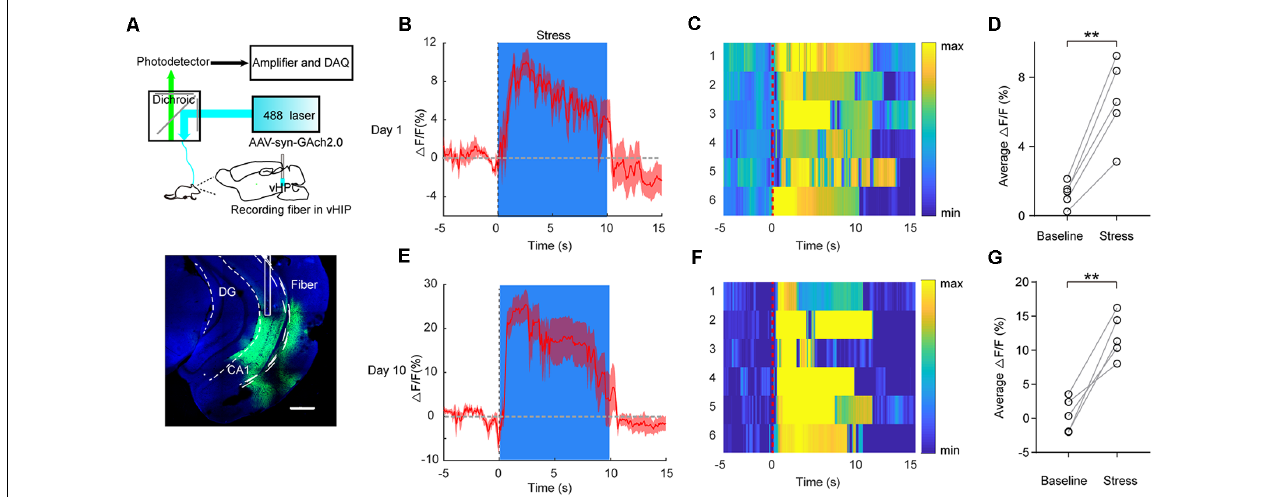
FIGURE 2 | Transient restraint stress increases ACh muscarinic receptor (mAChR) signal in behaving mice. (A) Left, schematic of the fiber photometry setup. Right, a representative image validates GAch2.0 expression (green) and optical fiber tract above the vHPC. Scale bar, 500 µ M. (B,C) PETH plot (B) and heat map (C) of fluorescence transients from a representative mouse aligned to the start of the restraint stress. (D) Quantification of change in fluorescence intensity before and after restraint stress ( N =5 mice). Paired Student’s t -test, t (4) = 7.754, p = 0.0015. PETH plot (E) and heat map (F) of fluorescence transients from a representative mouse, which went through 9 days of CRS, aligned to the start of restraint stress on day 10. (G) Quantification of change in fluorescence intensity before and after restraint stress ( N =5 mice). Paired Student’s t -test, t (4) = 6.399, p = 0.0031. The data are presented as the mean ± SEM, ** p < 0.01. The numbers of mice are shown in